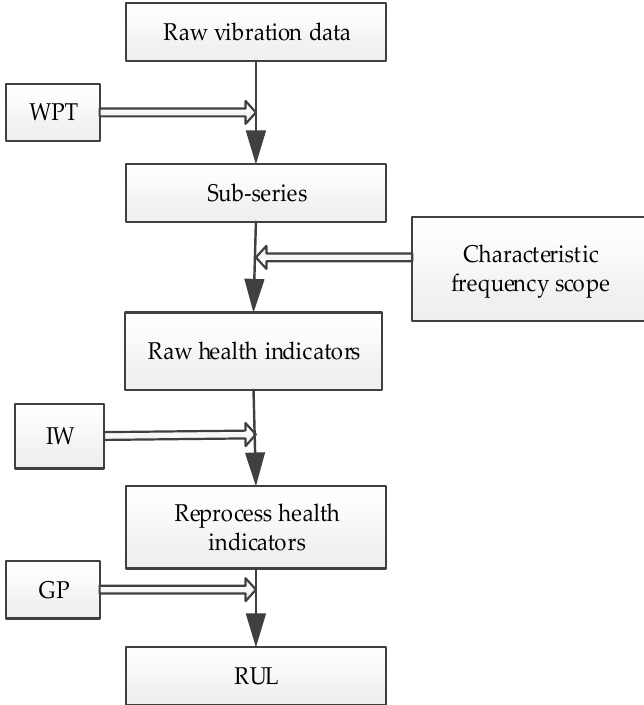
Figure 1. The block diagram of the proposed IWGP model.